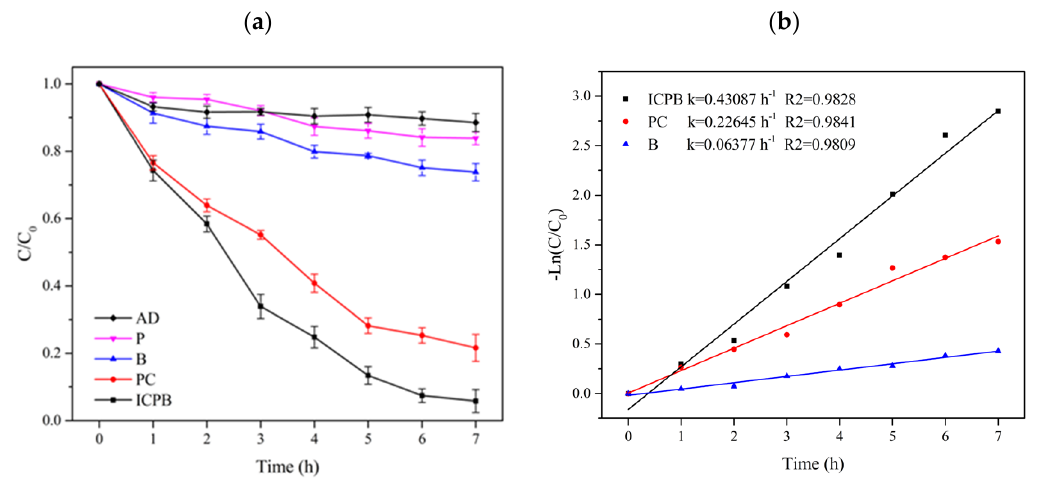
Figure 4. Curves of 1,2,4-TrCB degradation ( a ) and kinetics ( b ) in different protocols. AD—adsorp-tion without light and microorganisms; P—photolysis without carriers; B—biodegradation without light; PC—photocatalysis without microorganisms; ICPB—intimate coupling of biodegradation and photocatalysis.